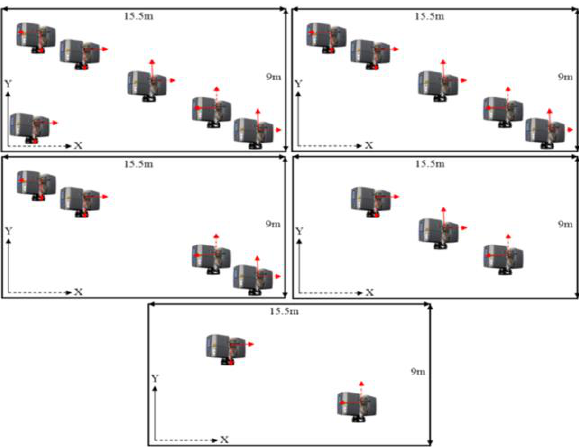
Figure 4. Reducing number of scan stations during self-